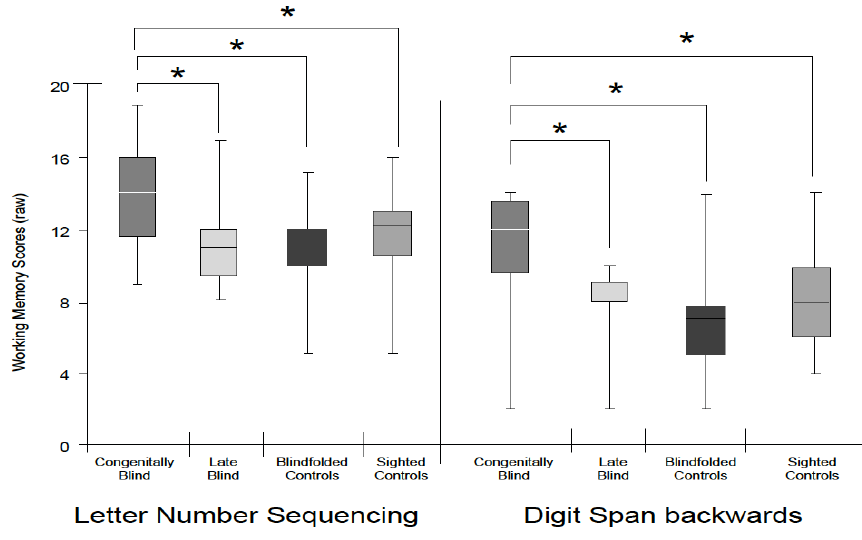
Figure 2. Group comparisons in the working memory tests scores. Bar graph comparing performance of congenitally blind, late blind, blindfolded, and sighted controls in the letter–number sequencing task ( left ) and the digit span backwards task ( right ). The congenital blind group performed better than all the other groups in both working memory tasks. * p < 0.05.